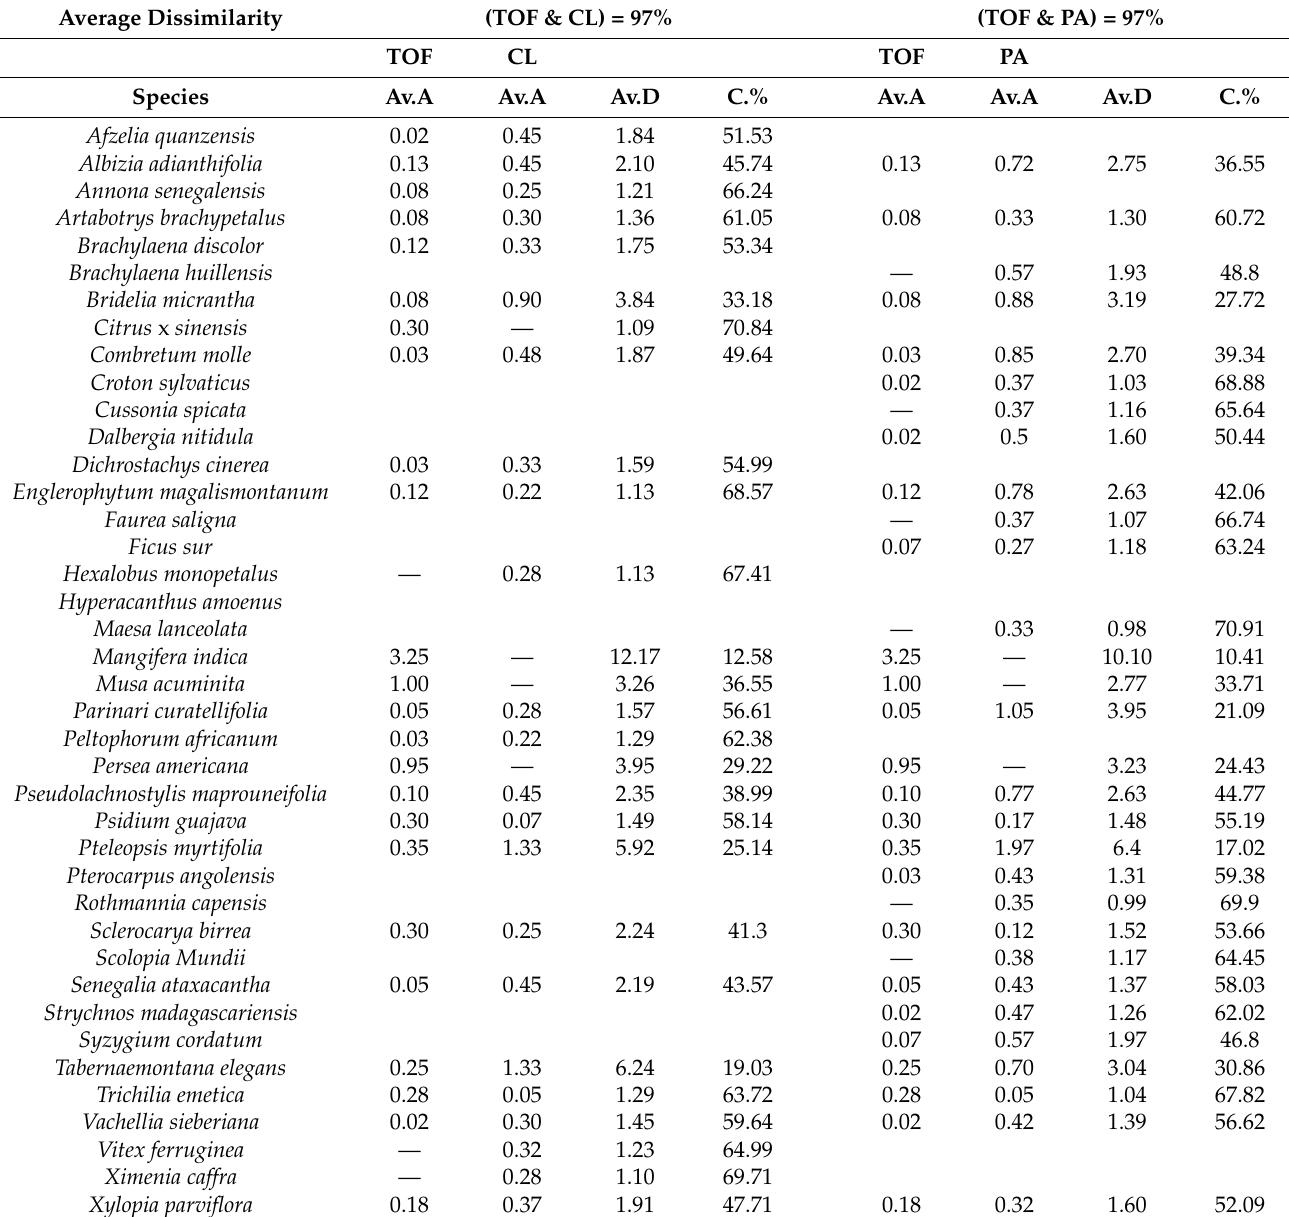
Table 7. Similarity Percentages (SIMPER) analysis of tree species abundance